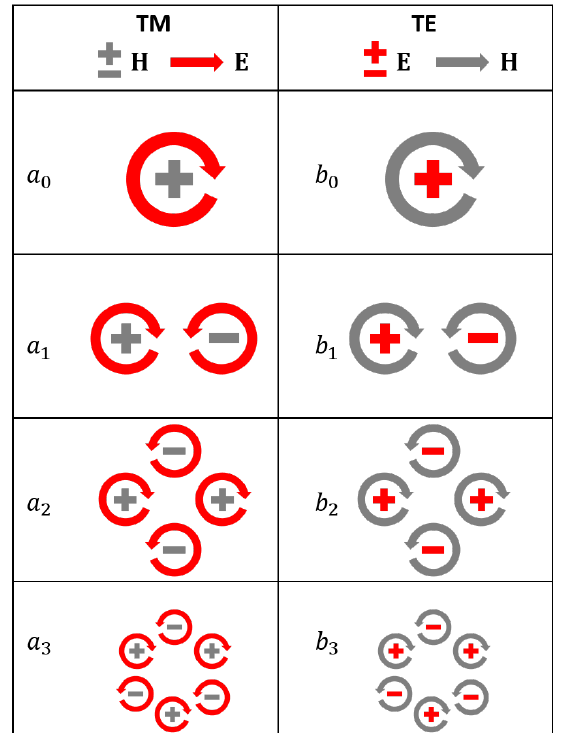
Figure 2. Field distribution in the scattering plane ( xy ) associated with the first four normal modes with TE and TM polarization.